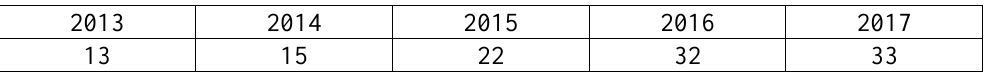
Table 2. Number of Isolated units